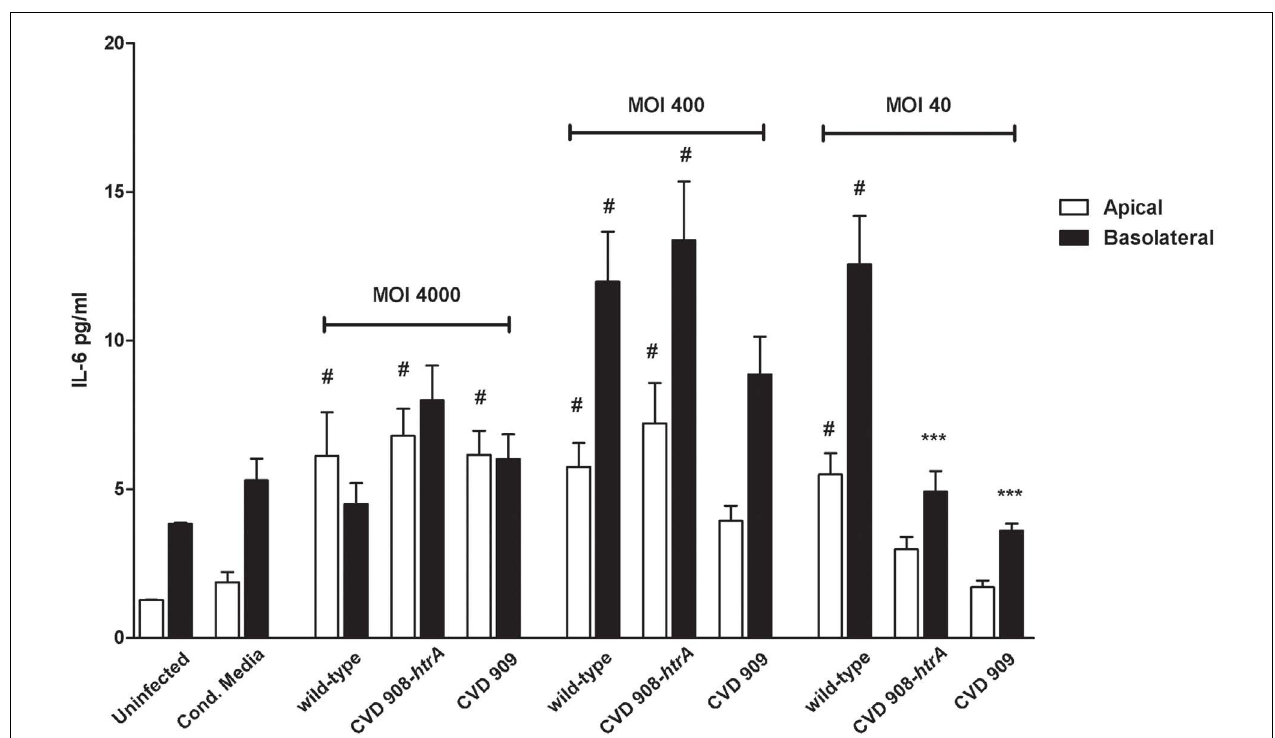
represent the mean ± SEM of three independent assays. # p < 0.05 over uninfected; *** p < 0.001, ** p < 0.01, * p < 0.05 for comparisons between wild-type S .Typhi and mutant strains applied at the same titer